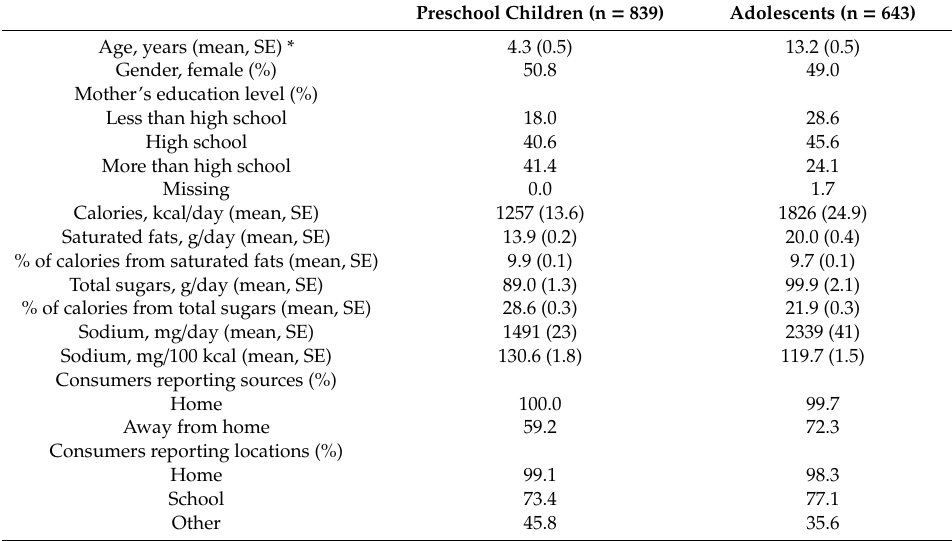
Table 1. Characteristics of the participants.